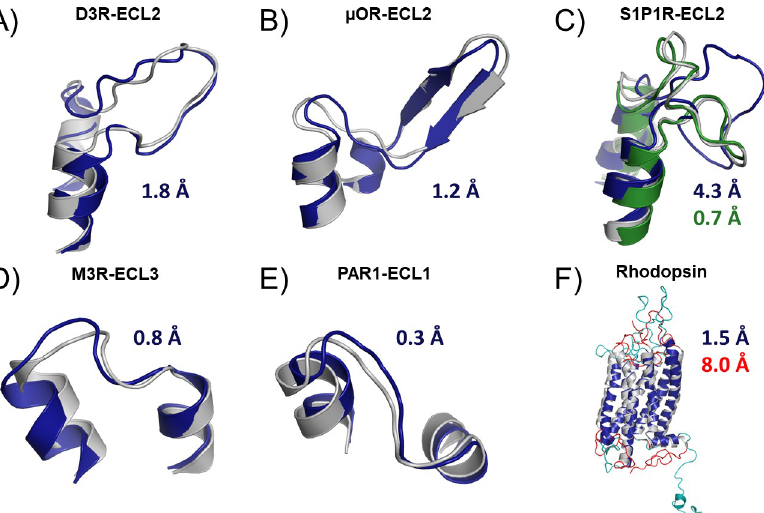
Fig 4. Examples of results obtainable with RosettaGPCR. In all cases, the crystal structure is colored grey and the model is blue. Three different ECL2 loops structures are presented: disordered (A), β -sheet (B), and lipid-binding (C). RosettaGPCR performs well on loops containing the conserved disulfide. For lipid receptors lacking the conserved disulfide (C) multiple templates (blue) perform worse than using a single template with similar structure (green), in this case the LPA receptor. Extracellular loops 3 (D) and 1 (E) also perform quite well with this method. In general, RosettaGPCR can model the TM region of most receptors below 2 Å (F). However, for receptors like rhodopsin with complex loop structures and termini (red), the model (cyan) fails to capture the overall conformation (8.0 Å